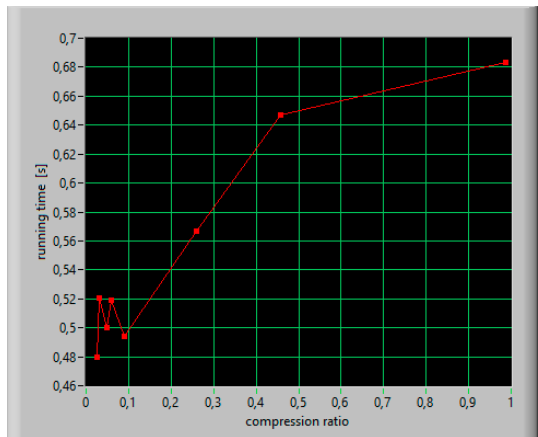
Figure 15. The running time versus compression ratio.